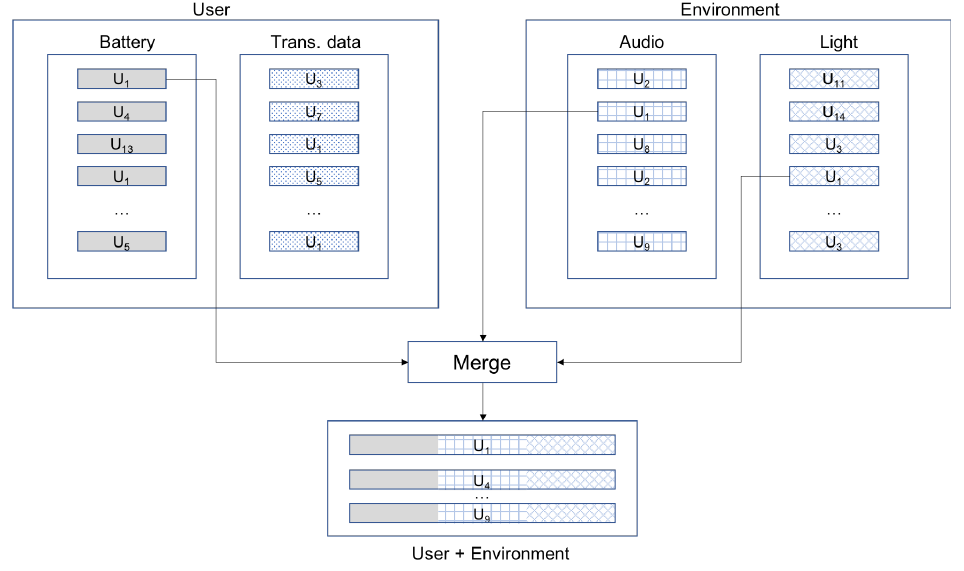
Figure 2. Data preparation for accuracy analysis (Audio + Light + Battery case).